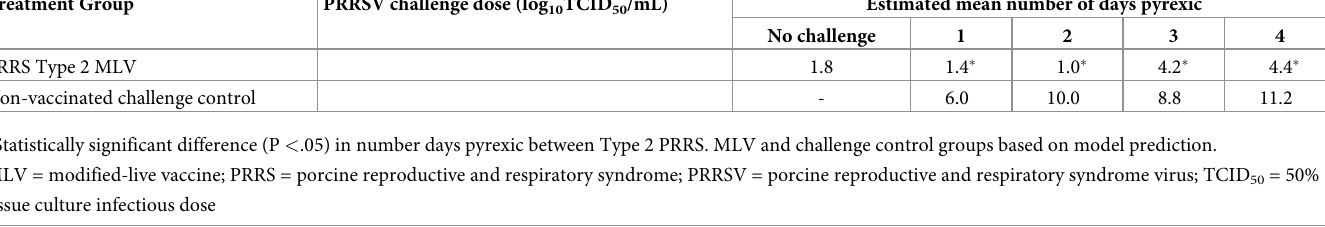
Table 2. Mean number of days vaccinated, challenged pigs were pyrexic compared with non-vaccinated pigs post-challenge. Treatment